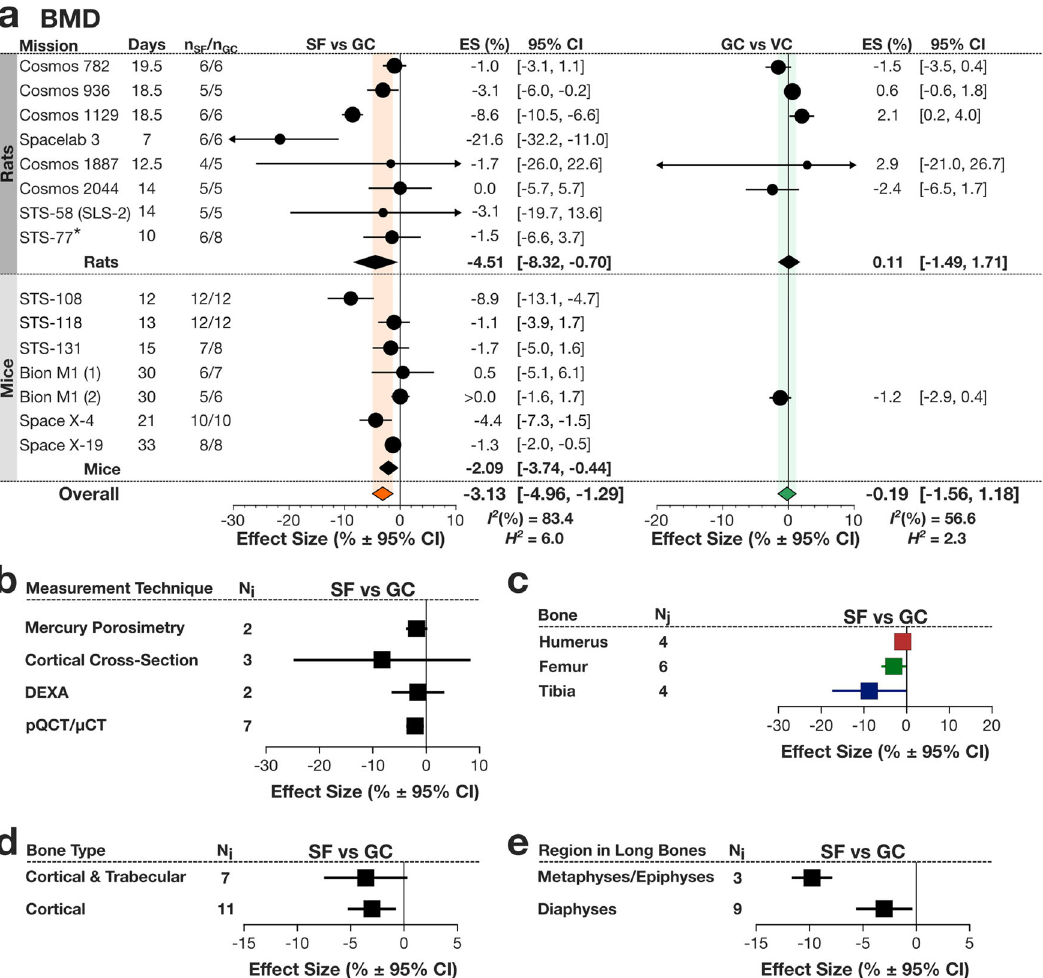
Fig. 5 Space fl ight-induced changes in bone mineral density (BMD) in rodents. a Forest plot of changes in BMD in space fl ight animals (SF) compared to ground control (GC) ( Left ); and GC compared to vivarium control animals (VC) ( Right ). Missions are strati fi ed by rodent species, and within each stratum, missions are ordered by mission year. Mission name, duration (Days), SF and GC sample sizes (n SF /n GC ) are shown. Circle/line: effect size (%) and 95% CI, the size of the circle is proportional to the mission ’ s weight. Black diamonds : overall effect size and 95% CI for mice and rats; color diamonds : overall effect size and 95% CI for rodents. I 2 and H 2 are for rodents. b Subgroup analysis of changes in BMD by measurement technique, which included density derived from weight of cortical cross-section sample divided by volume determined either from mercury displacement (Mercury Porosimetry) or from geometric estimates (Cortical Cross-Sectional), as well as BMD obtained from DEXA, or pQCT/ μ CT . c Subgroup analysis of long bone BMD by the forelimb and hindlimb bones. d Subgroup analysis of all BMD outcomes by the bone type. e Subgroup analysis of long bone BMD by bone region. Square/line: effect size (%) and 95% CI. N i number of mission level outcomes. N j number of measurement level outcomes.